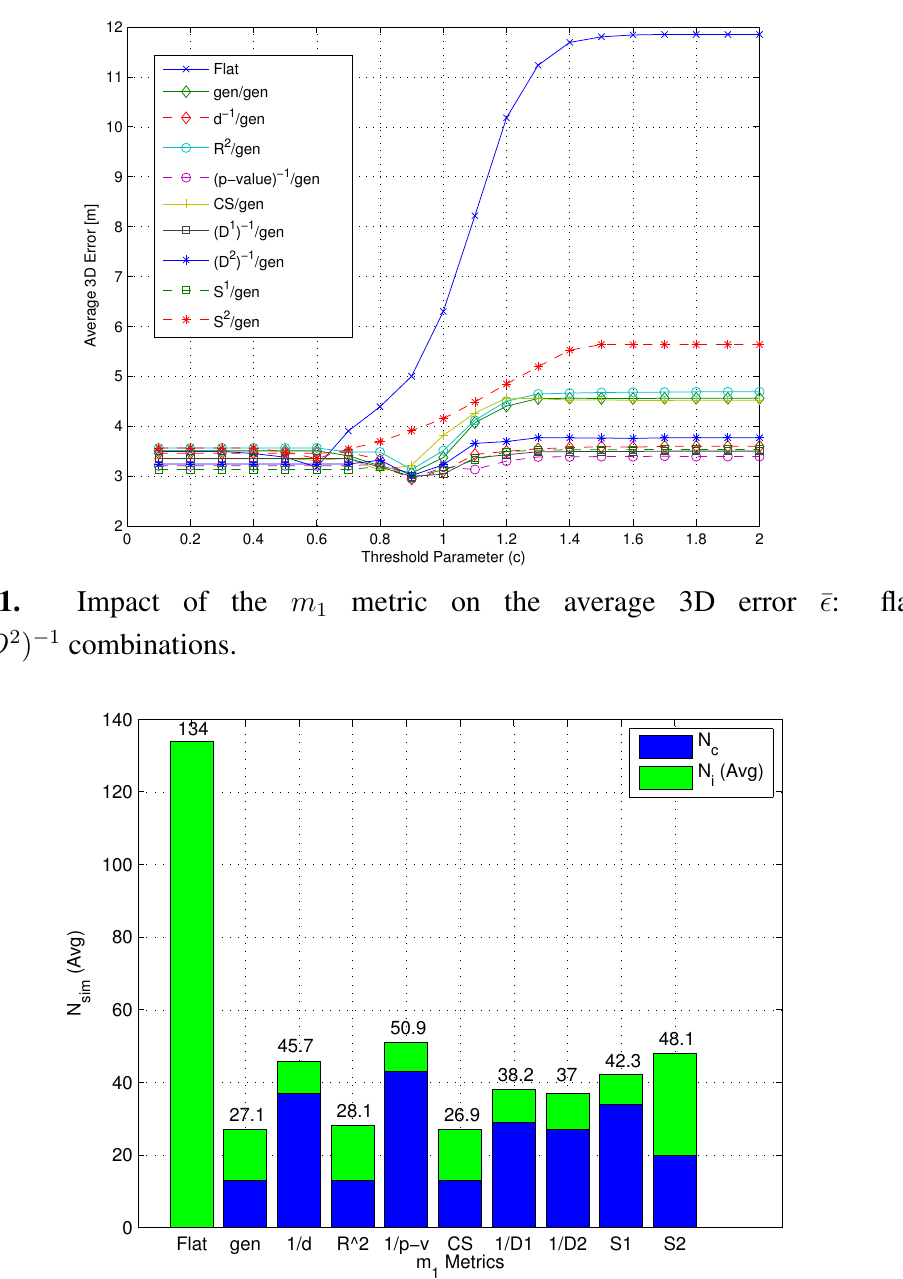
Figure 12. N for both flat and two-step algorithms (with several m sim